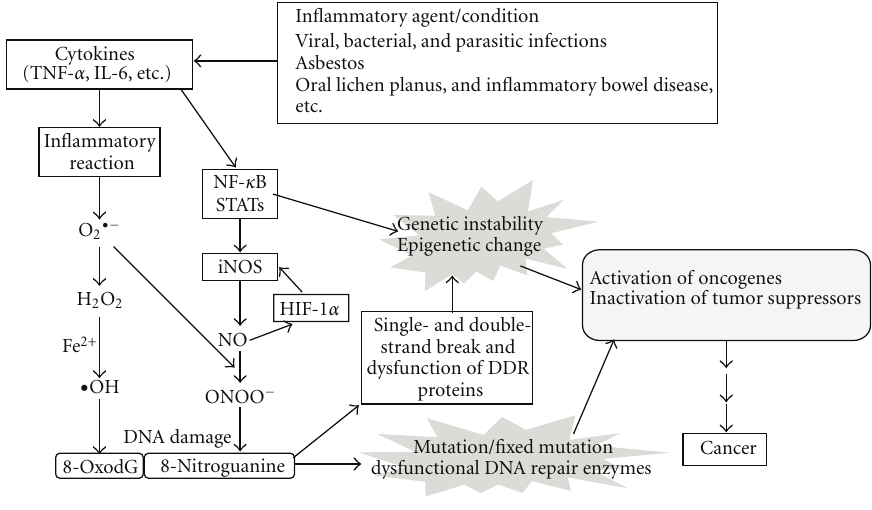
Figure 4: Proposed roles of nitrative and oxidative DNA damage in inflammation-related